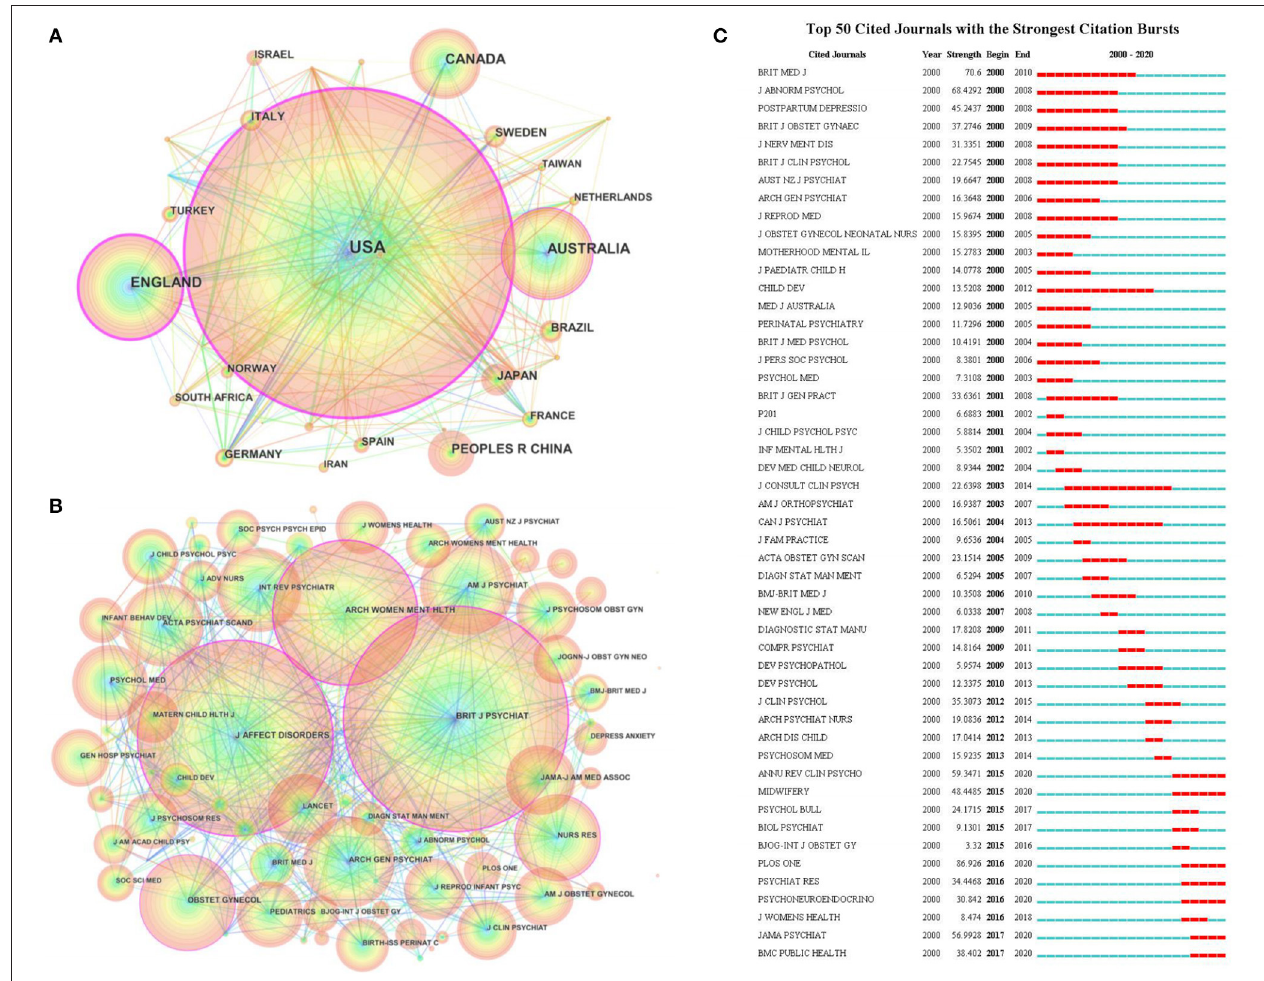
FIGURE 2 | Co-occurrence analysis of countries and journals. (A) The countries co-occurrence network knowledge map of PPD from 2000 to 2020. (B) The journals co-citation network knowledge map of PPD from 2000 to 2020. (C) Top 50 cited journals with the strongest citation bursts.